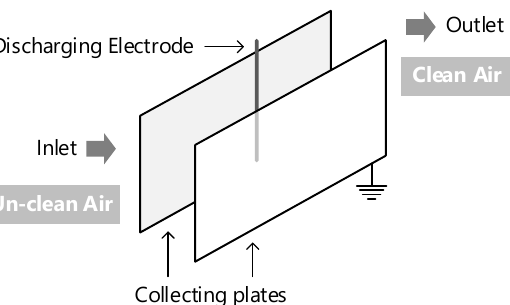
Figure 1. A 2D schematic of the electrostatic precipitator (ESP). The device consists of an air inlet, air outlet, and body housing the discharging electrode and collecting plates.